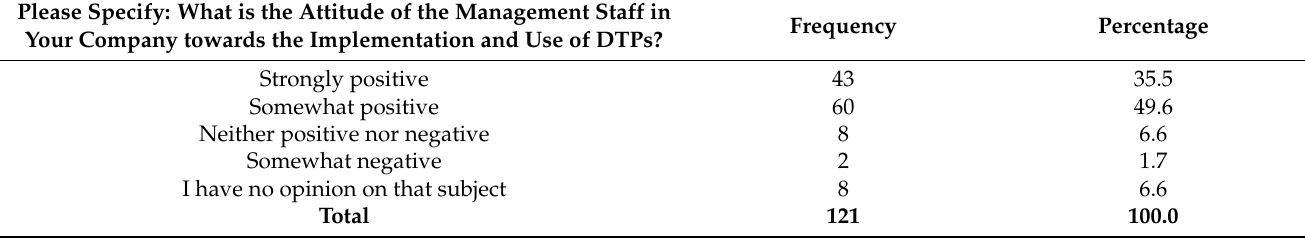
Table 2. The attitude of the management staff of surveyed companies towards